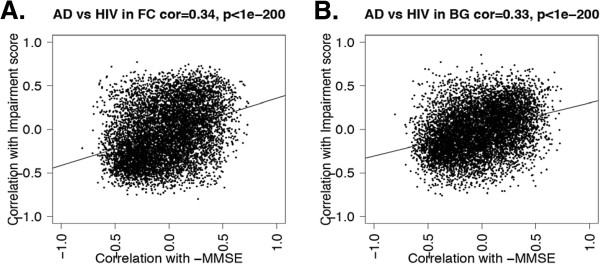
Common impairment marker genes across regions and diseases. Correlation between Impairment and gene expression in the hippocampus of Alzheimer’s disease is relatively consistent with correlation between impairment and gene expression in frontal cortex (A) and basal ganglia (B) of HIV-associated neurocognitive disorder. The x-axes represent correlation with GCR score in HIV brains, while the y-axes represent negative correlation with MMSE in the AD brains. Dots in the upper right of the plot represent genes whose increased expression in either HIV of AD would suggest impairment, while dots in the lower left represent genes whose decreased expression would suggest impairment.